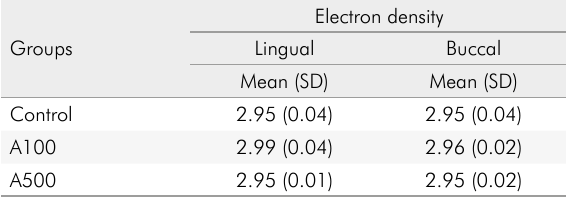
Table 1. Mean (SD) electron density on the lingual and buccal surfaces of the molars in each group. A100 =